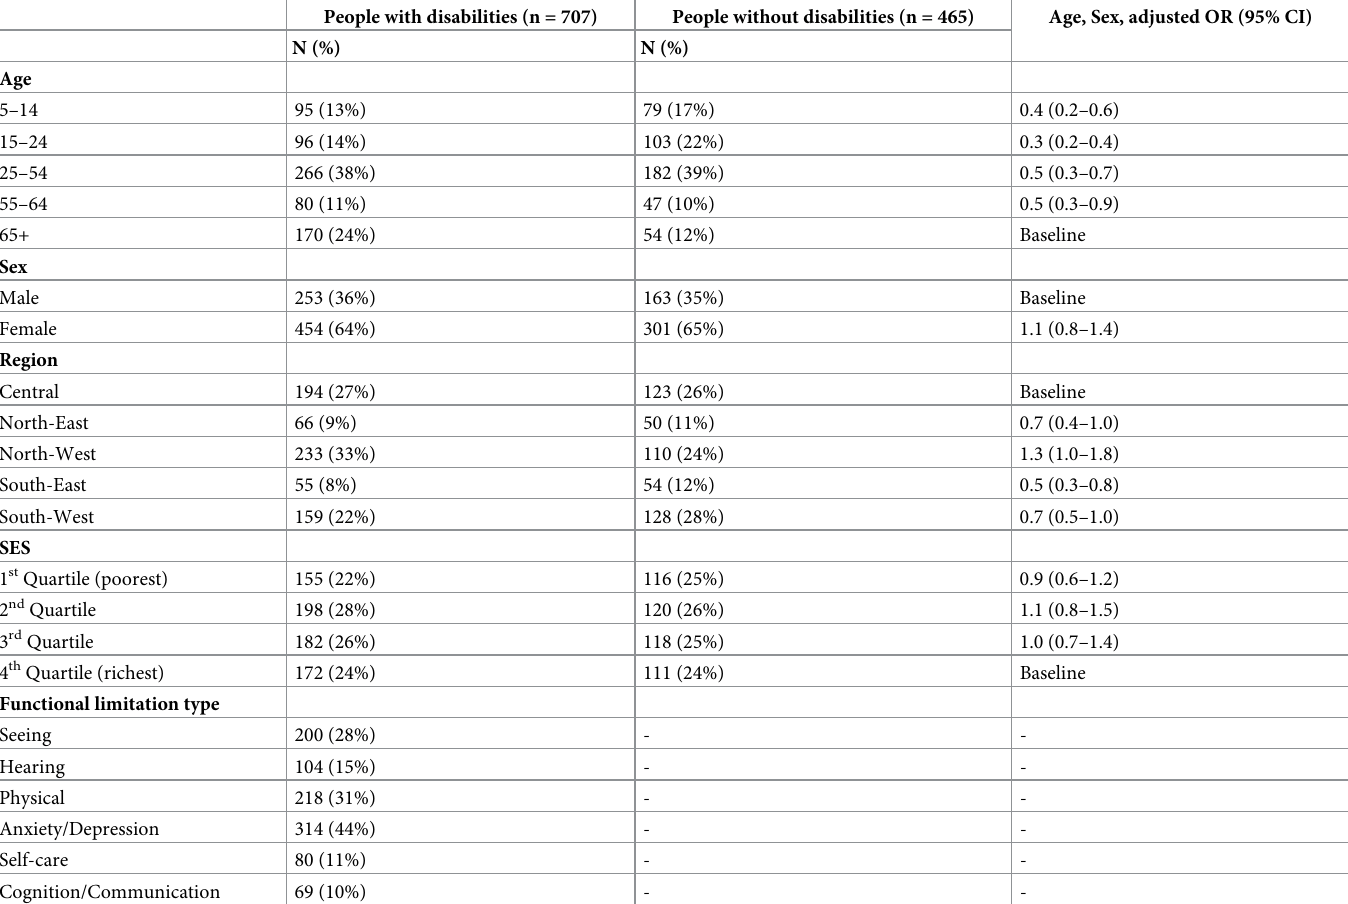
Table 1. Socio-demographic characteristics of people with and without